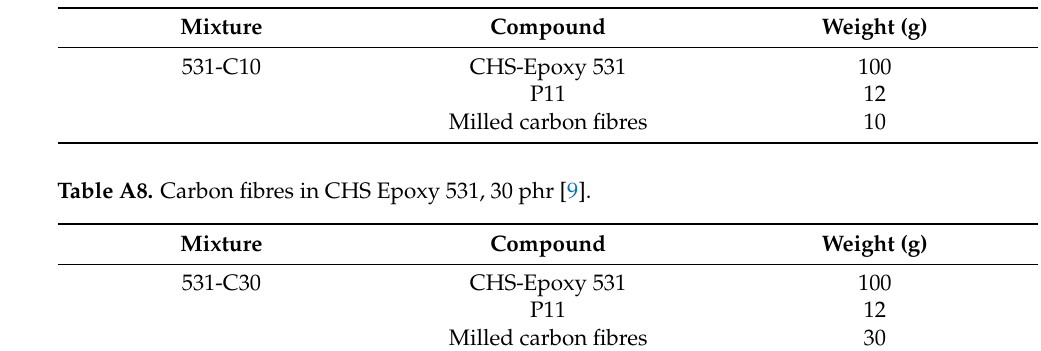
Table A7. Carbon fibres in CHS Epoxy 531, 10 phr [9].